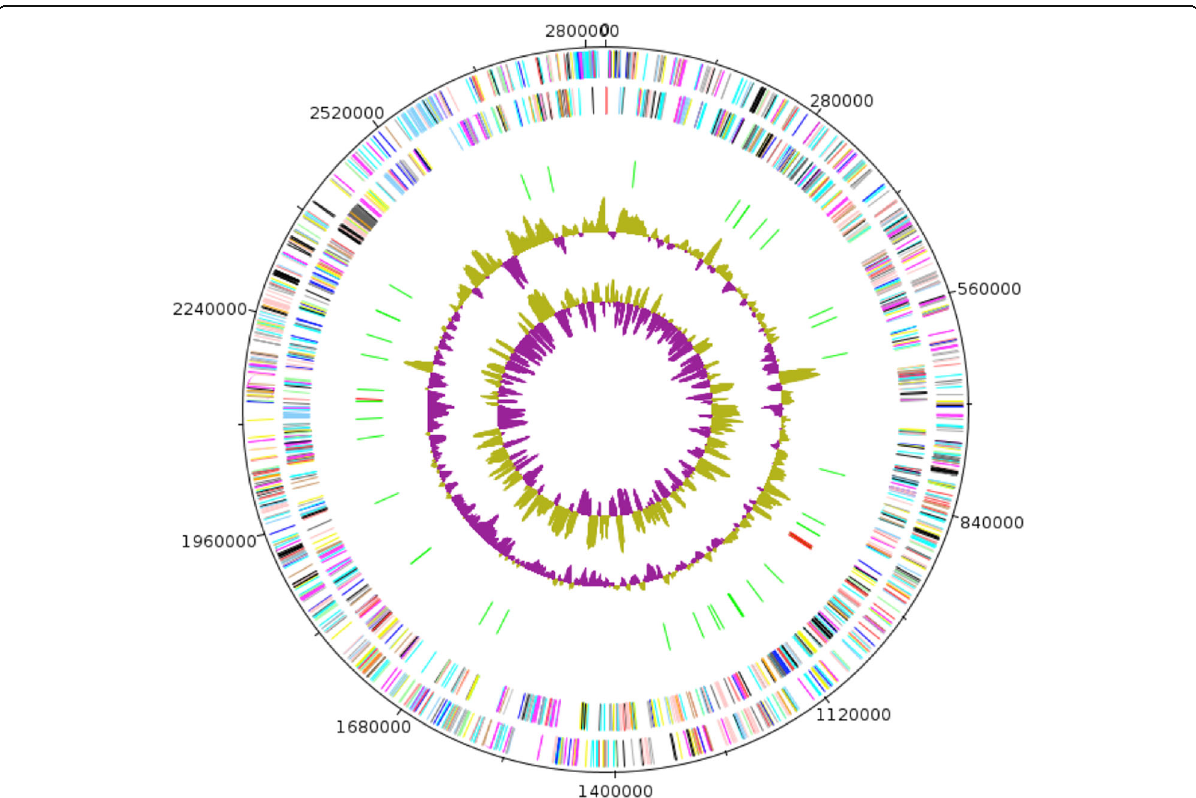
Fig. 5 Graphical circular map of the chromosome of Fermentimonas caenicola strain SIT8. From the outside in, the outer two circles show open reading frames oriented in the forward (coloured by COG categories) and reverse (coloured by COG categories) directions, respectively. The third circle marks the rRNA gene operon (red) and tRNA genes (green). The fourth circle shows the GC % content plot. The inner-most circle shows GC skew, purple indicating negative values and olive for positive